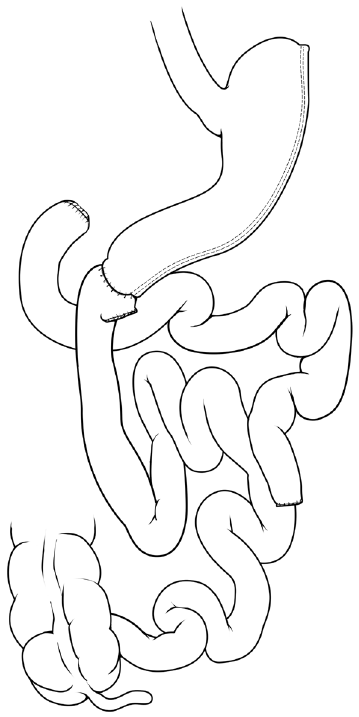
Figure 5. Biliopancreatic diversion with duodenal switch. As in traditional biliopancreatic diversion, bile and pancreatic secretions are diverted to the distal bowel for mixing with nutrients/chyme. The duodenal switch component, however, is accompanied by a vertical sleeve gastrectomy for reduction of gastric